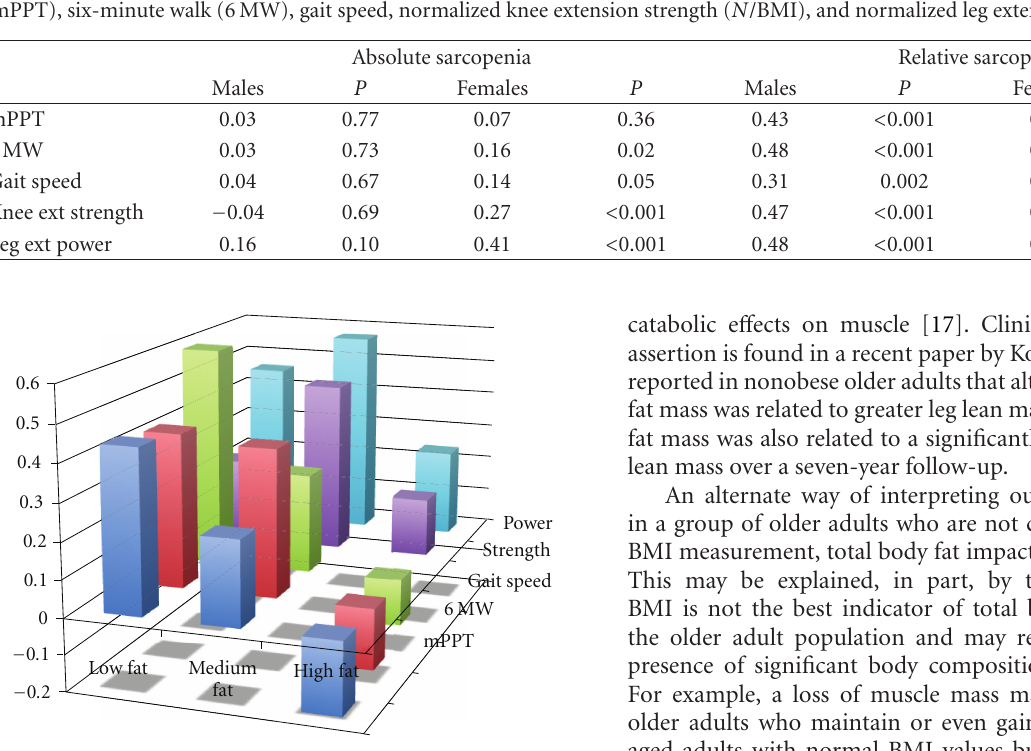
Figure 1: Standardized regression coe ffi cients between absolute sarcopenia scores (independent variable) and mPPT score, 6- minute walk distance, gait speed, knee extensor strength, and lower extremity power (dependent variables) across equal low (34 males, 33 females), medium (34 males, 33 females), and high-fat (34 males, 34 females)